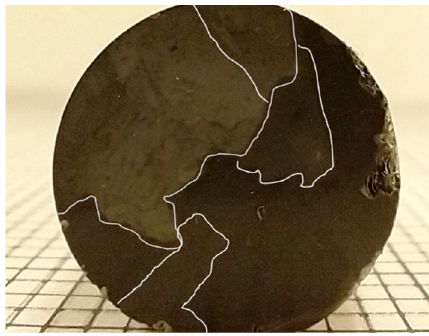
Figure 7. Cross-sectional view of a Cd 0.9 Zn 0.1 Te 0.97 Se 0.02 ingot grown using a VBM method at U of SC. The grain boundaries have been emphasized with white lines for ease of visualization.